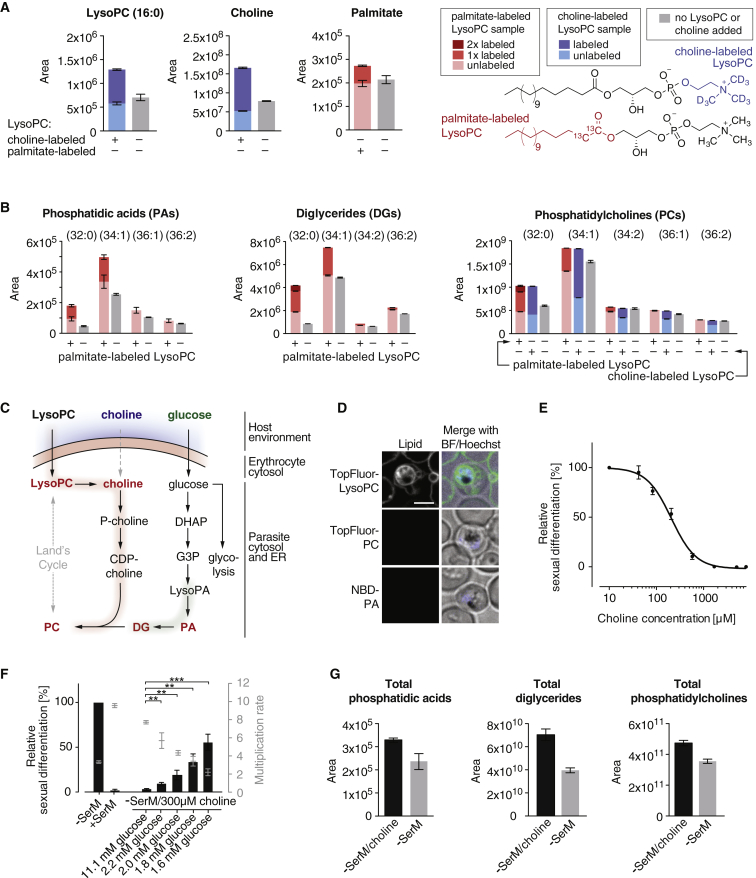
LysoPC Is Metabolized and Drives PC Biosynthesis via the Kennedy Pathway(A) Addition of heavy-isotope-labeled LysoPC increases levels of palmitate and choline in parasites. Bars show chromatographic areas under the curve. Colors indicate the contribution of labeled and unlabeled molecules to the total peak areas. n = 3, standard errors of the means are shown. 13C palmitate LysoPC or 2H choline LysoPC was used.(B) Levels of parasite phosphatidic acids (PAs), diglycerides (DGs), and phosphatidylcholines (PCs) are significantly increased in presence of LysoPC and elevated lipids contain LysoPC-derived building blocks. Bars show chromatographic areas under the curve. Colors indicate the contribution of labeled and unlabeled molecules to the total peak areas. n = 3, standard errors of the means are shown.(C) The Kennedy pathway requires CDP-choline and DGs deriving from LysoPC and glycolysis products, respectively, for PC synthesis. LysoPA, lysophosphatidic acid; DHAP, dihydroxyacetone phosphate; G3P, glycerol-3-phosphate; PA, phosphatidic acid; P-choline, phosphocholine; CDP-choline, cytidine diphosphate choline; DG, diglyceride.(D) Live cell microscopy shows inefficient incorporation of fluorescent Kennedy metabolites PC (TopFluor-labeled) and PA (nitrobenzoxadiazole [NBD]-labeled) compared to LysoPC (TopFluor-labeled). Scale bar, 4 μm. Representative pictures are shown.(E) Choline inhibits sexual differentiation at super-physiological concentrations (IC50 of 207 μM; 95% CI 169–253 μM); human serum contains ∼10 μM choline (Psychogios et al., 2011). Activity of choline was assayed in presence of 11.1 mM glucose in −SerM medium. n = 3, standard errors are shown.(F) In absence of exogenous LysoPC, glucose is required in addition to excess choline to inhibit sexual differentiation, reiterating the importance of Kennedy-mediated PC synthesis in this process. n = 3, standard deviations are shown, ∗∗ p < 0.01, ∗∗∗ p < 0.001, Student’s t test.(G) In presence of glucose, exogenously added choline mirrors the effect of LysoPC and elevates levels of parasite PA, DG, and PC. n = 3, standard errors of the means are shown.See also Figure S2 and Dataset S1.